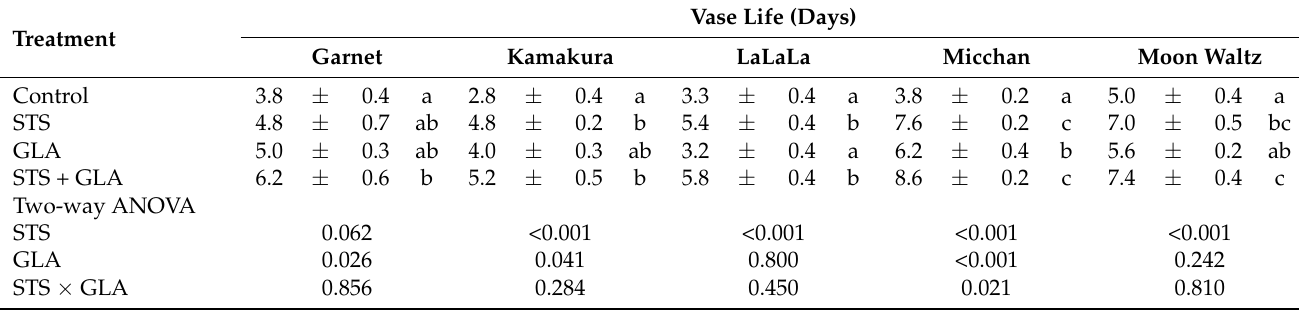
Table 3. Effect of pulse treatment with STS followed by continuous treatment with GLA on the vase life of five dahlia